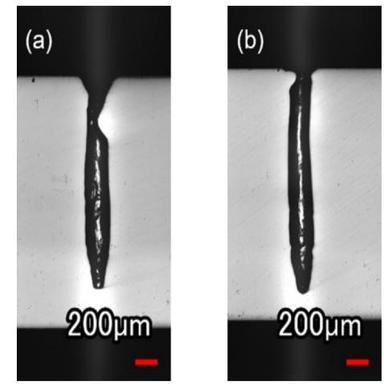
Comparison of semi-circular sections for the blind holes drilled using one laser pulse (a) without and (b) with water-based ultrasonic vibrations.